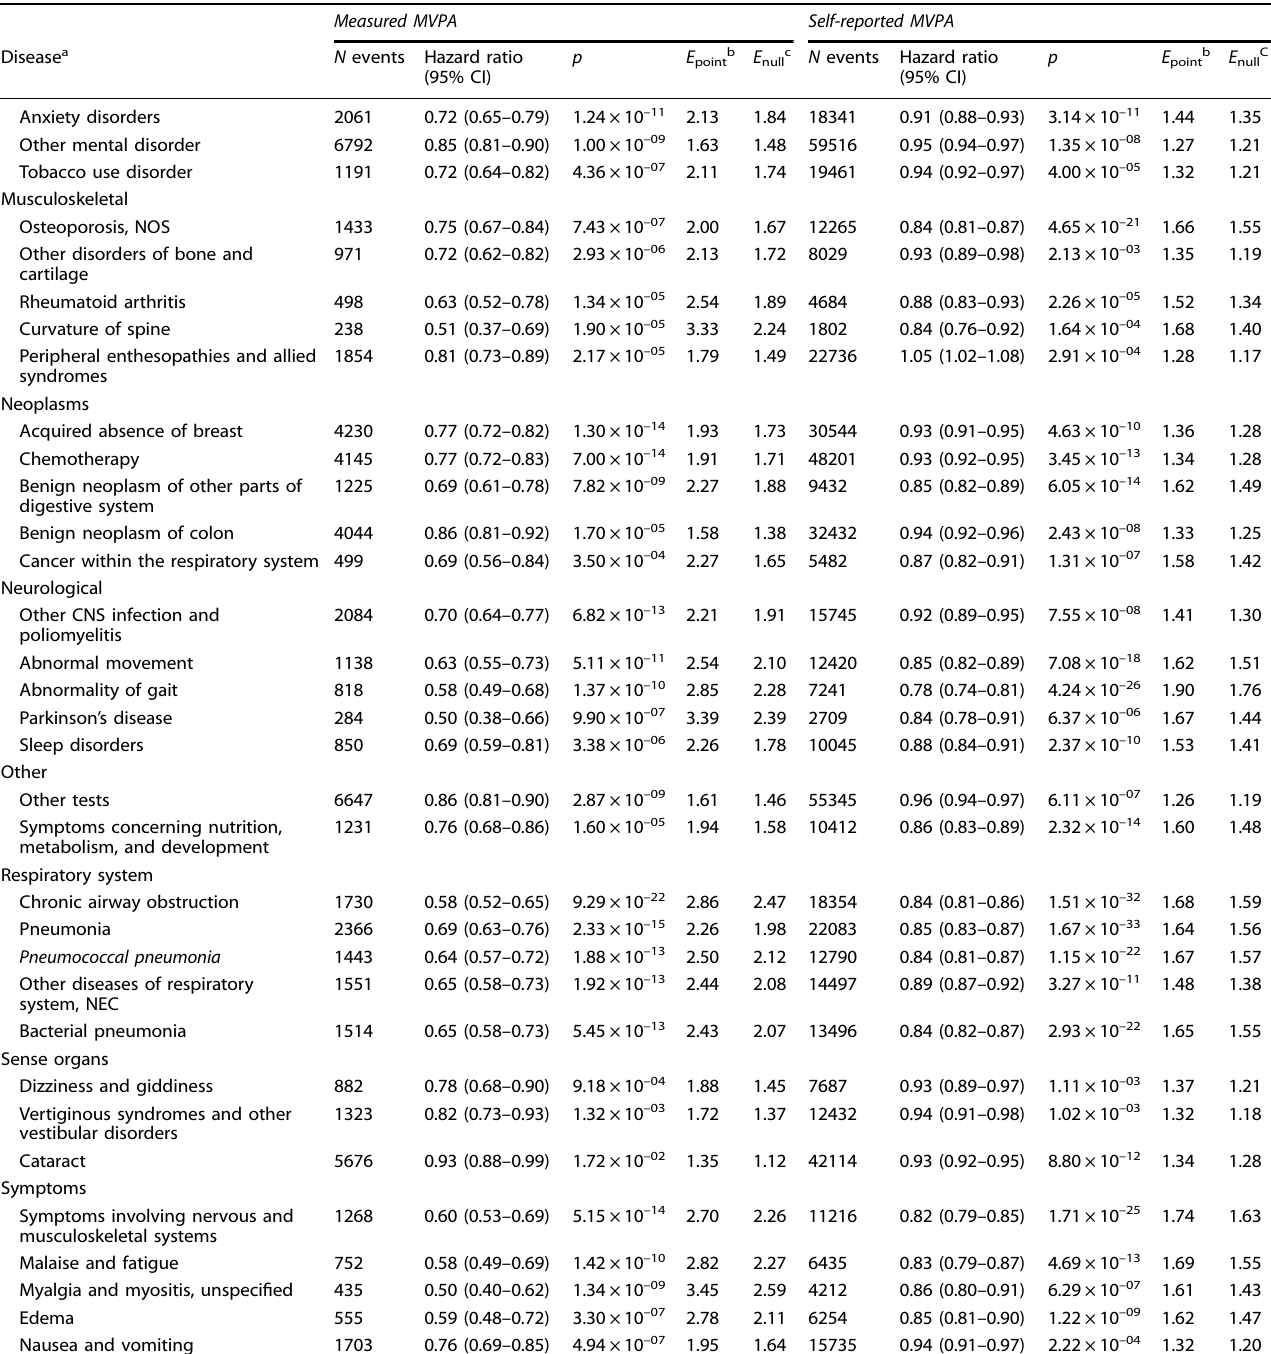
a Displayed are the top fi ve (when present) diseases with each category having the strongest statistical associations with guideline-adherent measured MVPA, among diseases associated with both measured and self-reported guideline-adherent MVPA at a false discovery rate of 1% (see text). For display purposes, disease entities represented multiple times (e.g., hypertension, essential hypertension) are shown only once (unabridged results in Supplementary Data). b E -value for the point estimate. The E -value is de fi ned as the minimum strength of association on the risk ratio scale that an unadjusted confounder would need to have with the exposure and the outcome to nullify the observed association. Higher values represent a lower likelihood the observed association is due to confounding. c E -value for the bound closest to the